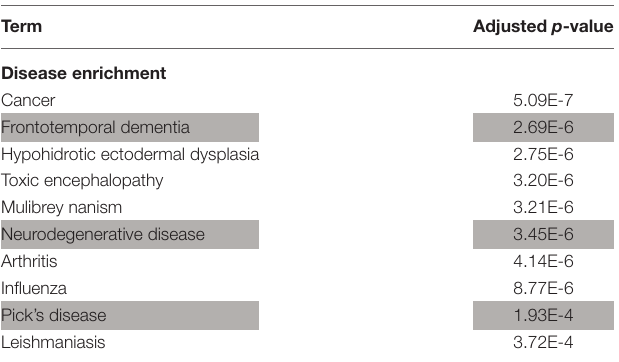
TABLE 3 | Enrichment analysis of TRAF6 partners